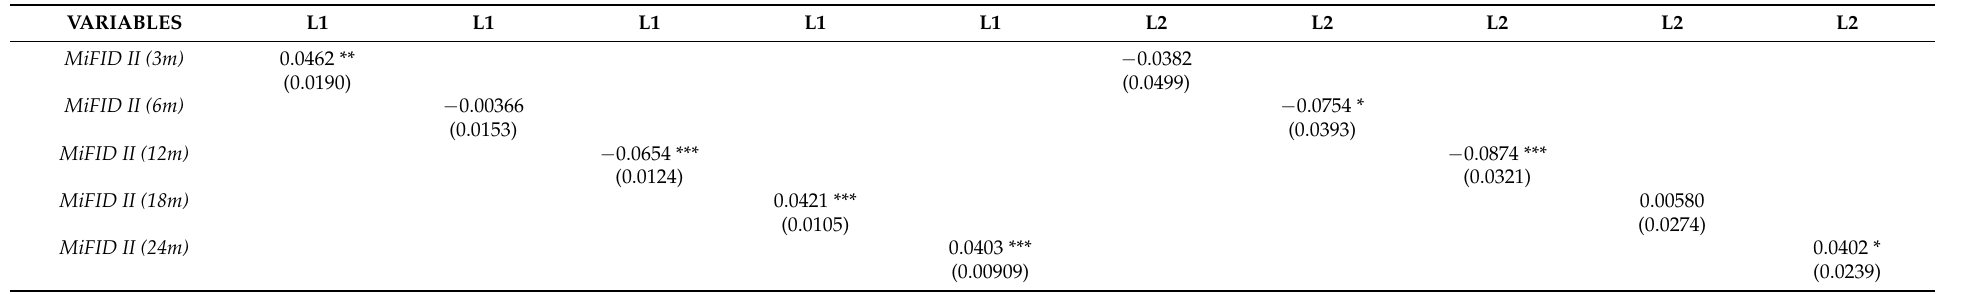
Table 4. Impact of MiFID II on German stock market